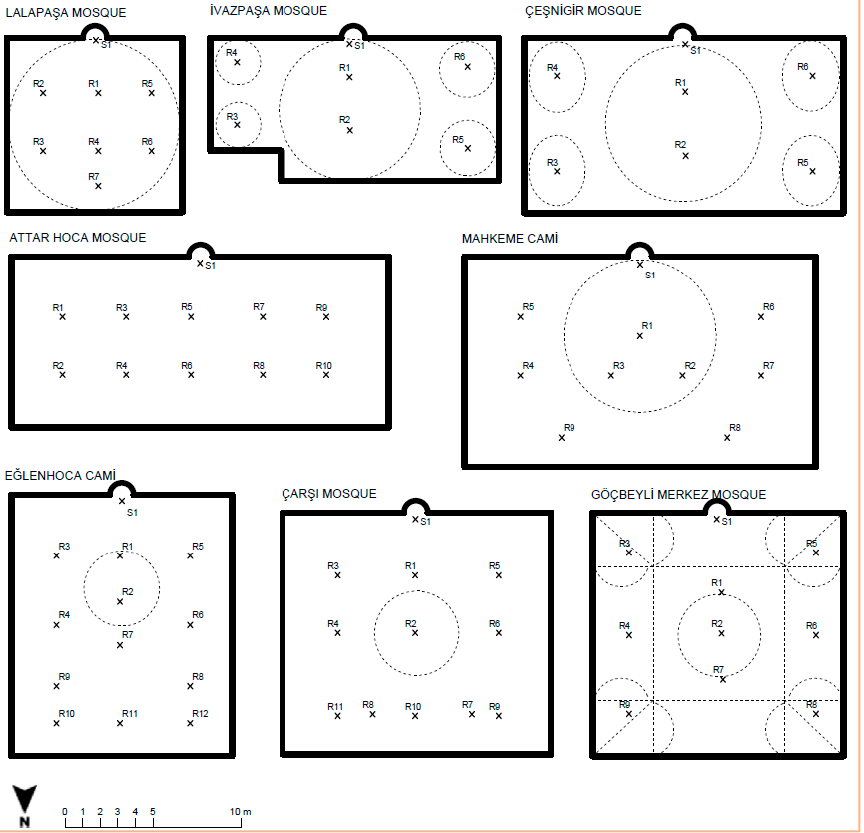
Figure 10. Sound sources and receiver points determined in the field measurements of selected